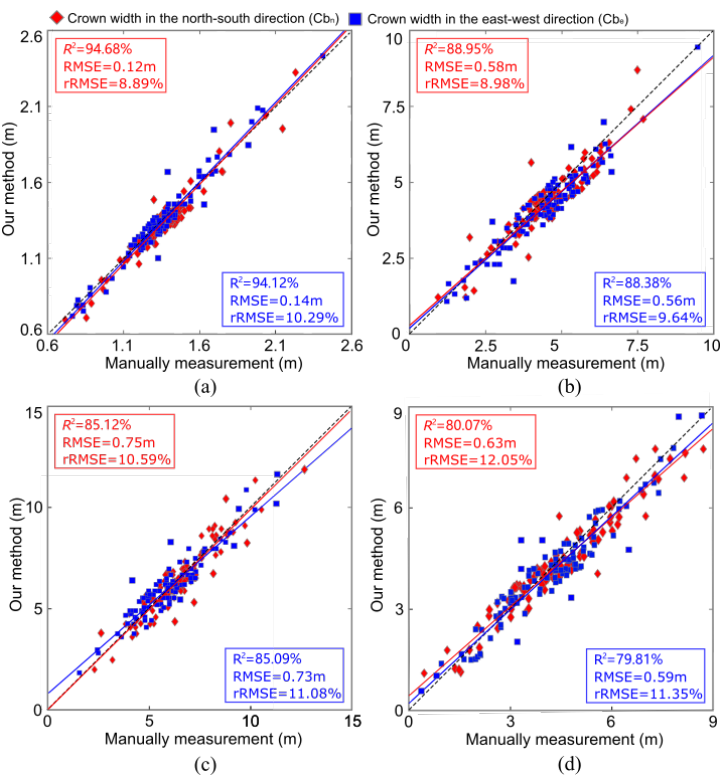
Figure 9. Scatter plots illustrating the comparison results of the crown width obtained by field measurements versus our method for the four different forest types, i.e., ( a ) nursery base, ( b ) monastery garden, ( c ) mixed forest, and ( d ) defoliated